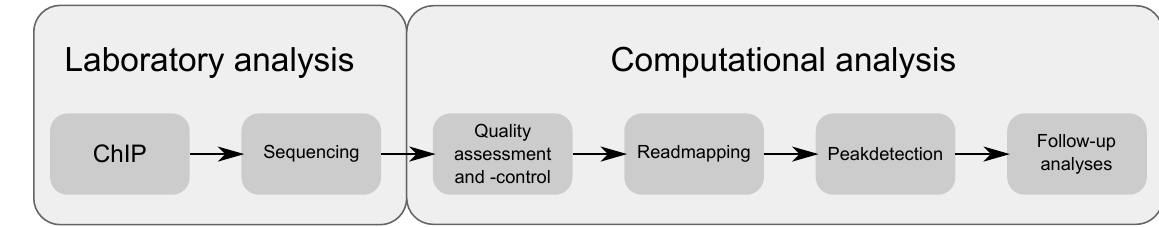
Figure 1: The typical workflow of a ChIP-seq experiment can be divided into a laboratory and a computational part. The laboratory part covers chromatin-immunoprecipitation (ChIP) and massively parallel sequencing. The computational data analysis part consist of four sequentially performed steps. Namely, (1) the quality control and assessment of short reads, (2) their mapping against a reference genome and (3) the derivation of putative interaction sites. In a final step (4) various follow-up analyses to elucidate the biological implications of identified interaction sites can